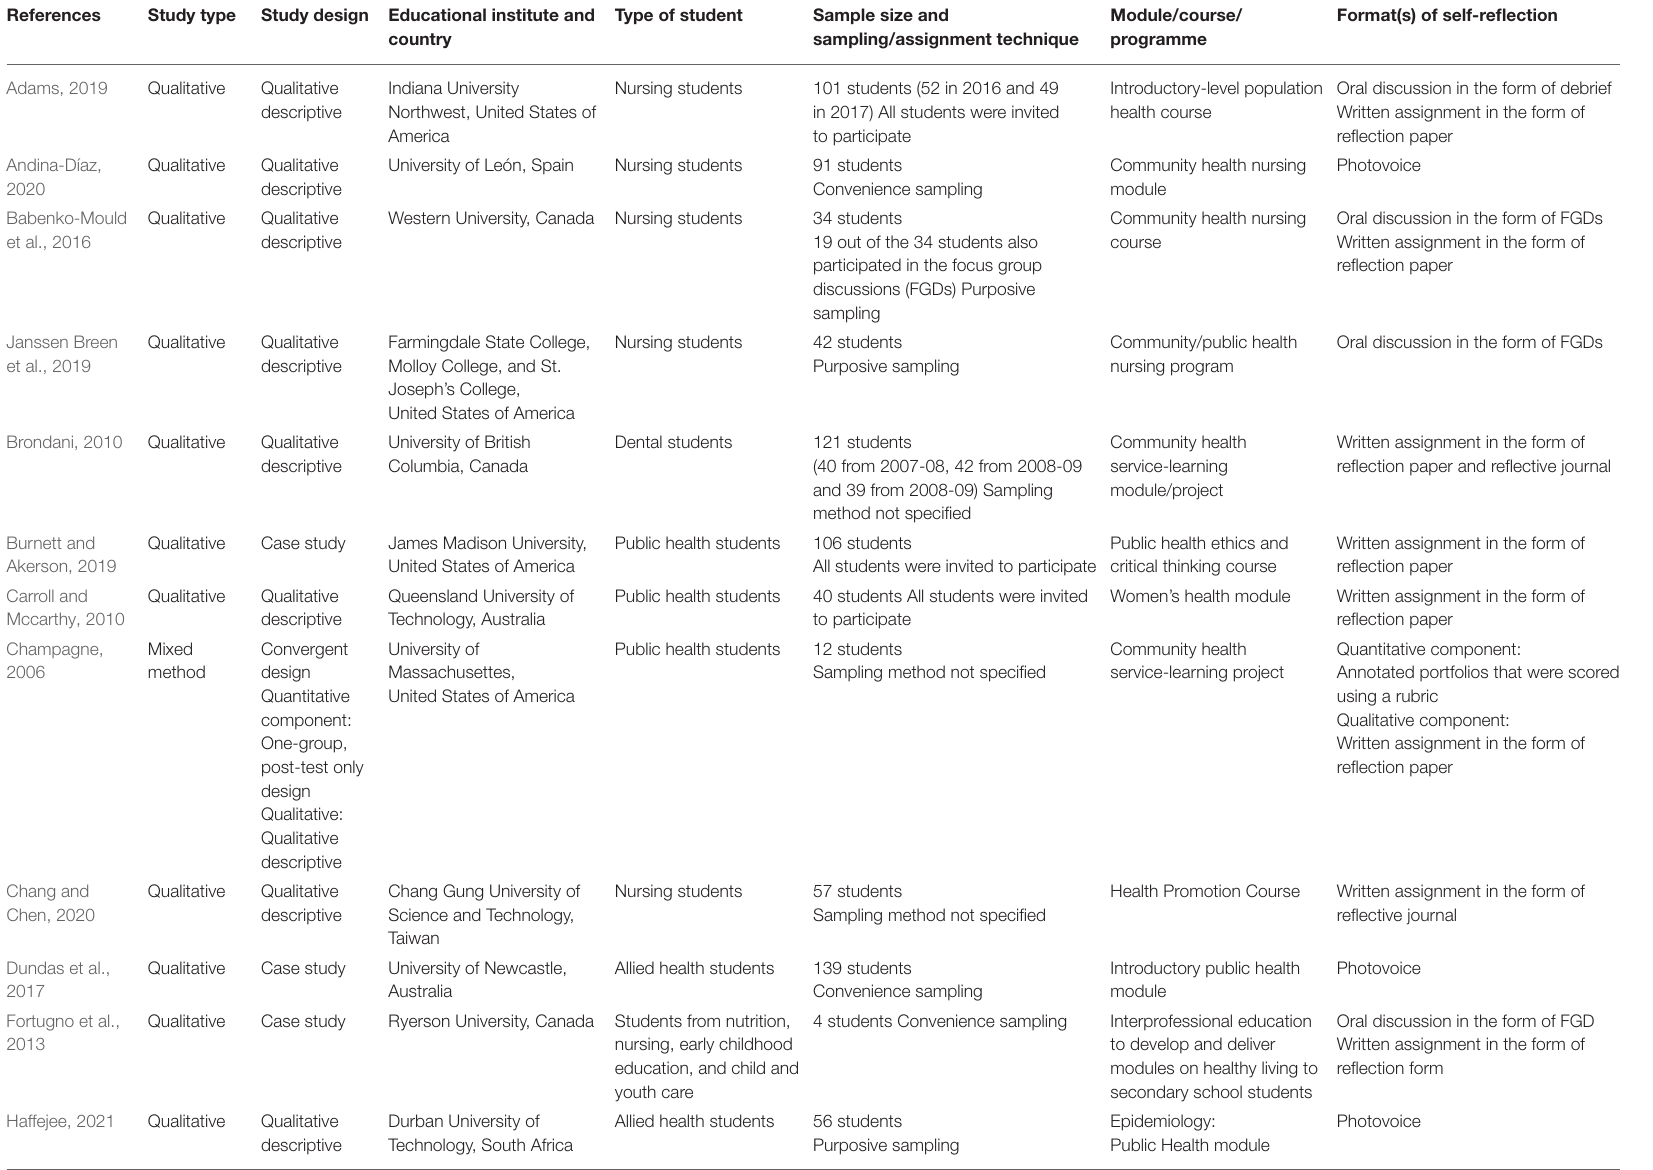
TABLE 1 | Characteristics of included